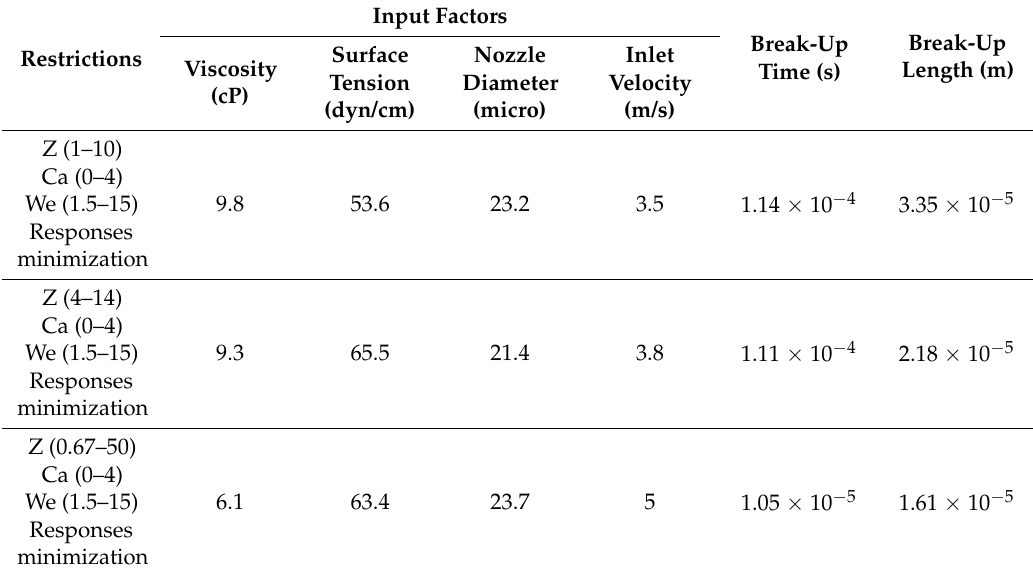
Table 4. Multi-optimization using jettability and printability